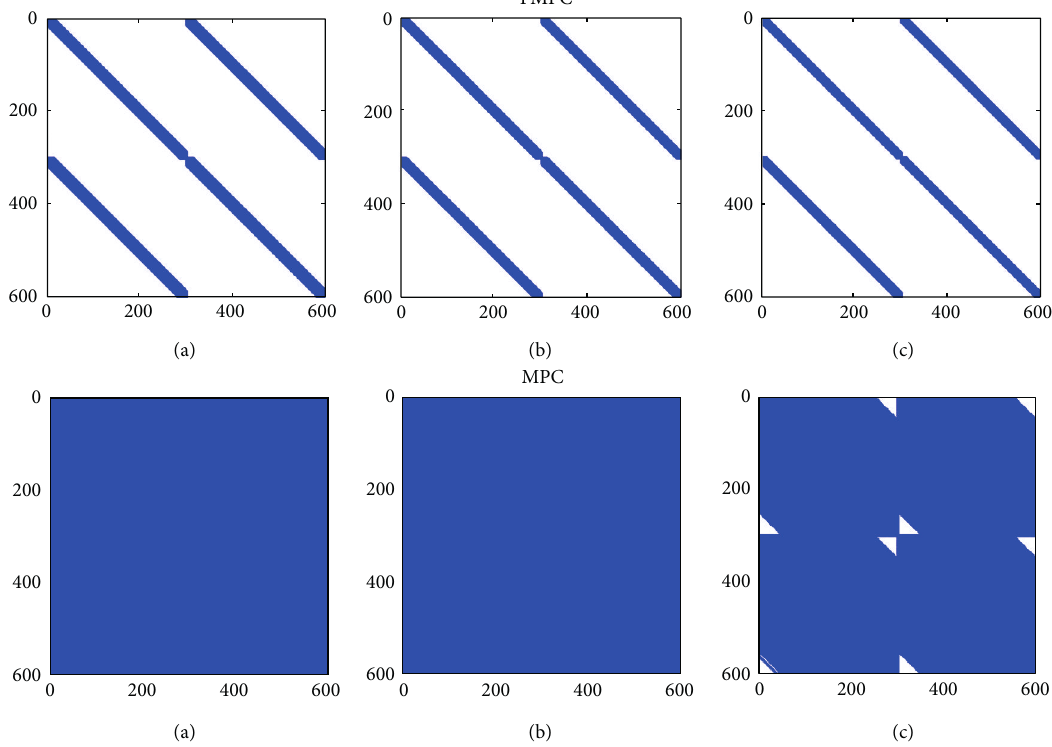
Figure 11: Effect of the number of prediction points on the structure of the state matrix: FMPC (a) Case 1 ( 𝑁 = 5 , 𝑛𝑧 = 35100 ), (b) Case 2 ( 𝑁 = 10 , 𝑛𝑧 = 28800 ), and (c) Case 3 ( 𝑁 = 15 , 𝑛𝑧 = 25338 ); MPC (a) Case 1 ( 𝑁 = 5 , 𝑛𝑧 = 360000 ), (b) Case 2 ( 𝑁 = 10 , 𝑛𝑧 = 359880 ), and (c) Case 3 ( 𝑁 = 15 , 𝑛𝑧 = 359880